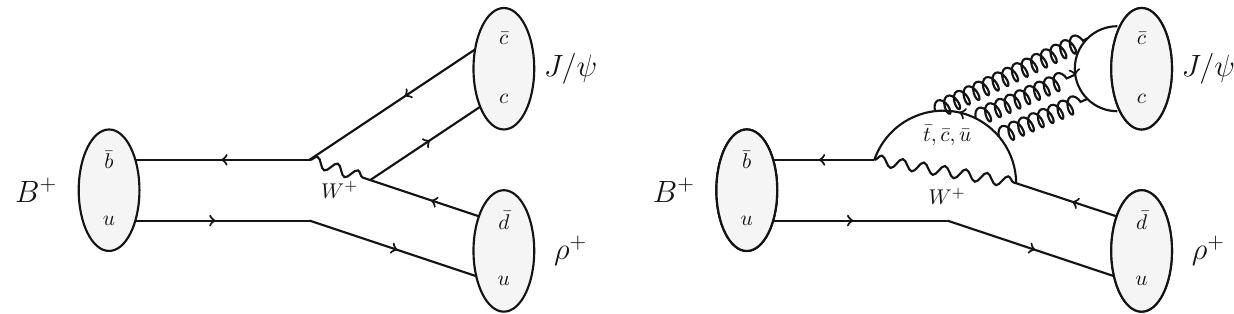
Fig. 1 Leading-order Feynman diagrams for the (left) tree and (right) penguin amplitudes contributing to the decay B + → J /ψ ρ